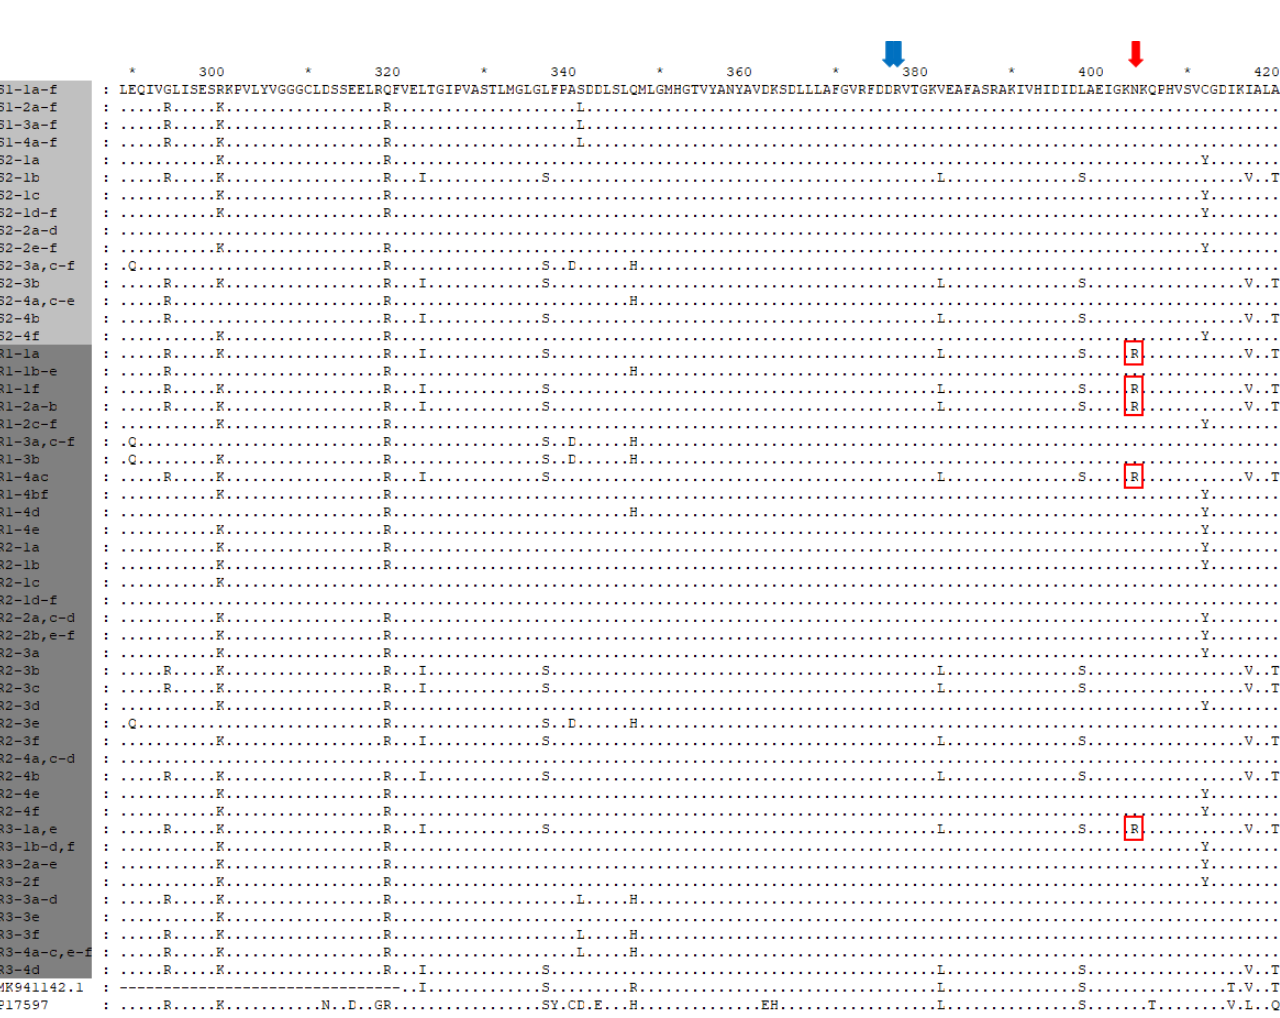
Figure 2. The alignment of Centaurea cyanus ALS amino acid sequences encompassing thiamine pyrophosphate enzyme, central domain. The sequences were derived from the plants susceptible (S) and resistant (R) to Lumer 50 WG. The numbers in sequence names represent the plant number; a–f—clone name; MK941142— C. cyanus ALS sequence GenBank accession number (the nucleotide sequence was translated to amino acid sequence); P17597— Arabidopsis thaliana ALS amino acid sequence GenBank accession number. The red frames and red arrows indicate amino acid mutations found in C. cyanus R plants. The blue arrows indicate the positions of mutations known for conferring resistance to ALS-inhibiting herbicides at positions D376 and R377, respectively. The amino acid numbering refers to A. thaliana ALS sequence.